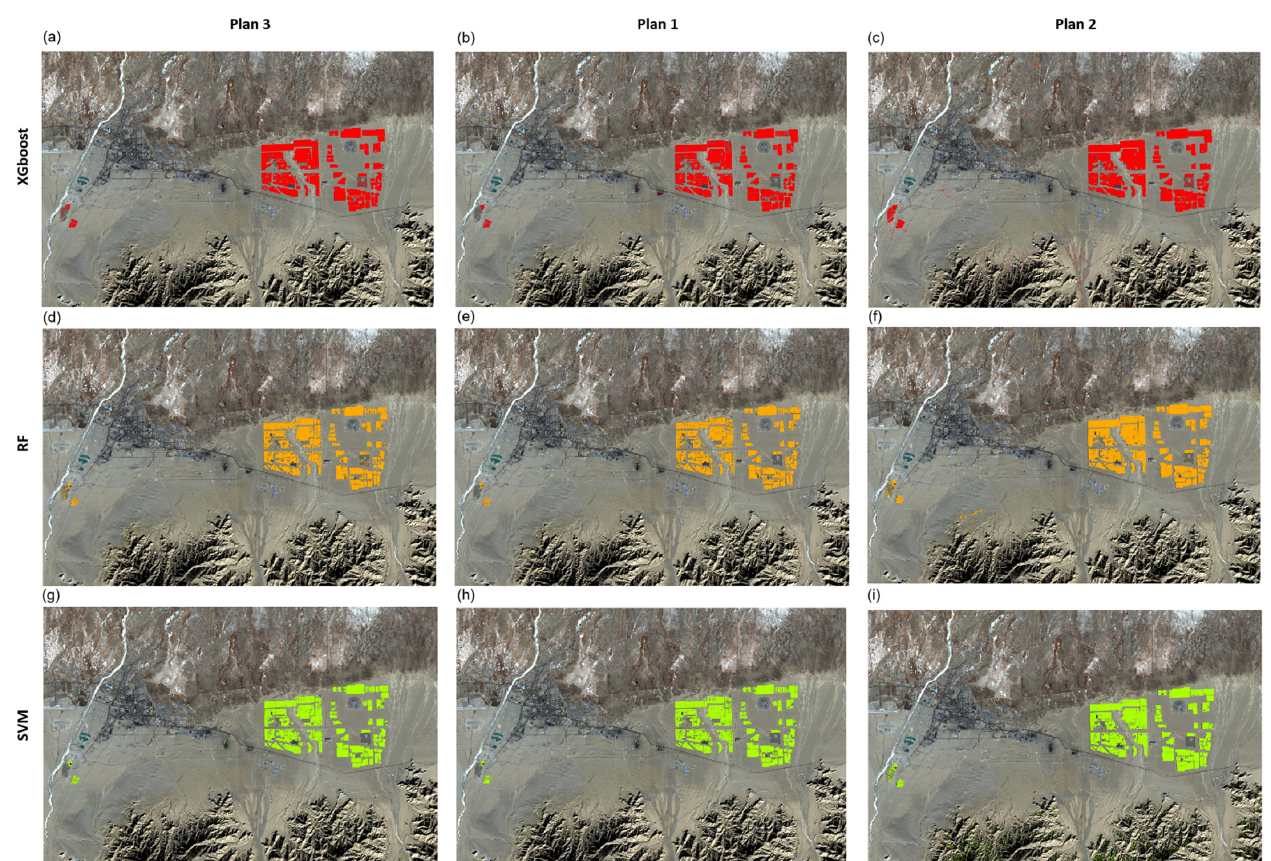
Table 7. Confusion matrix of the highest overall accuracy classifications.